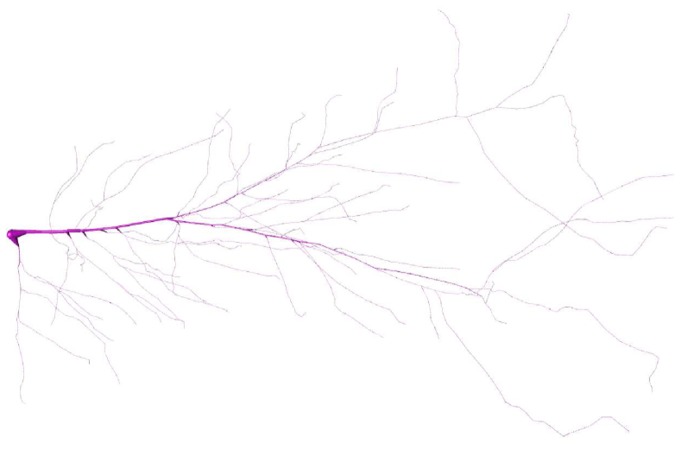
Segmented dendritic tree [51].This adapted version is visualized with Vaa3D [63]. The tree consists of 57 branching points and 879 elements.